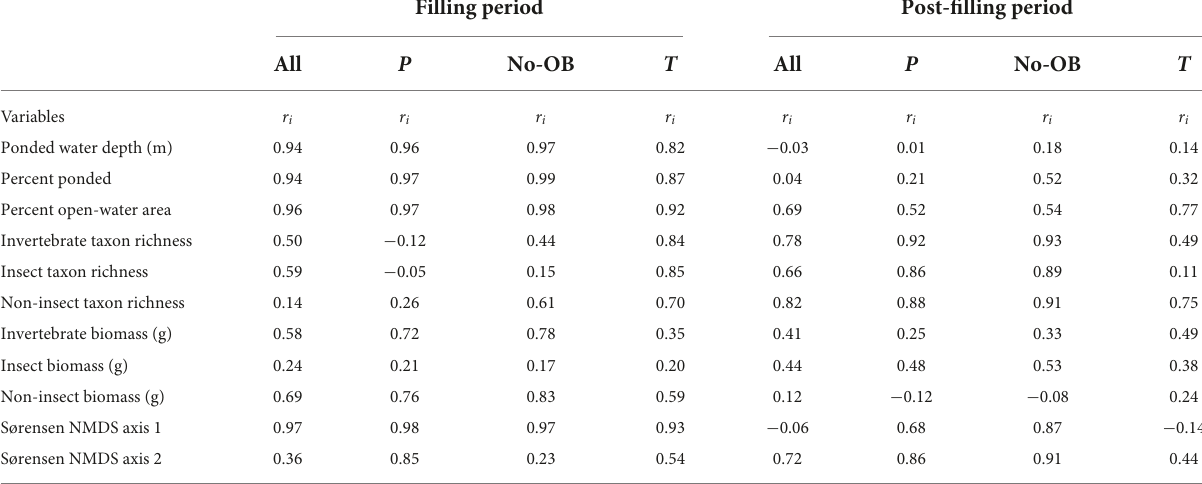
TABLE 4 Intraclass correlation coefficient ( r i ) among all wetlands ( n = 16), just P wetlands ( n = 8), P wetlands excluding OB wetlands ( n = 6), and just T wetlands ( n = 8) sampled during the filling hydroclimatic period (1992–2000) and the post-filling hydroclimatic period (2001–2015). Filling